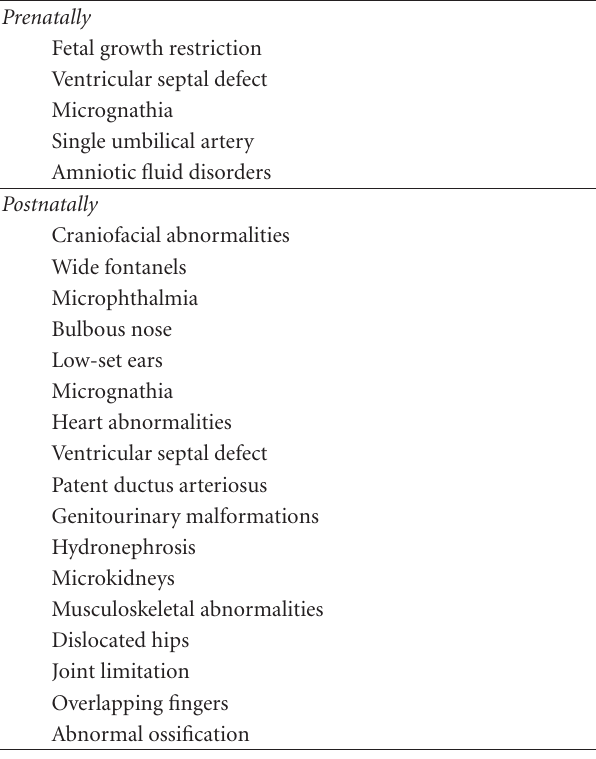
Table 1: Clinical findings of trisomy 9 mosaicism with high